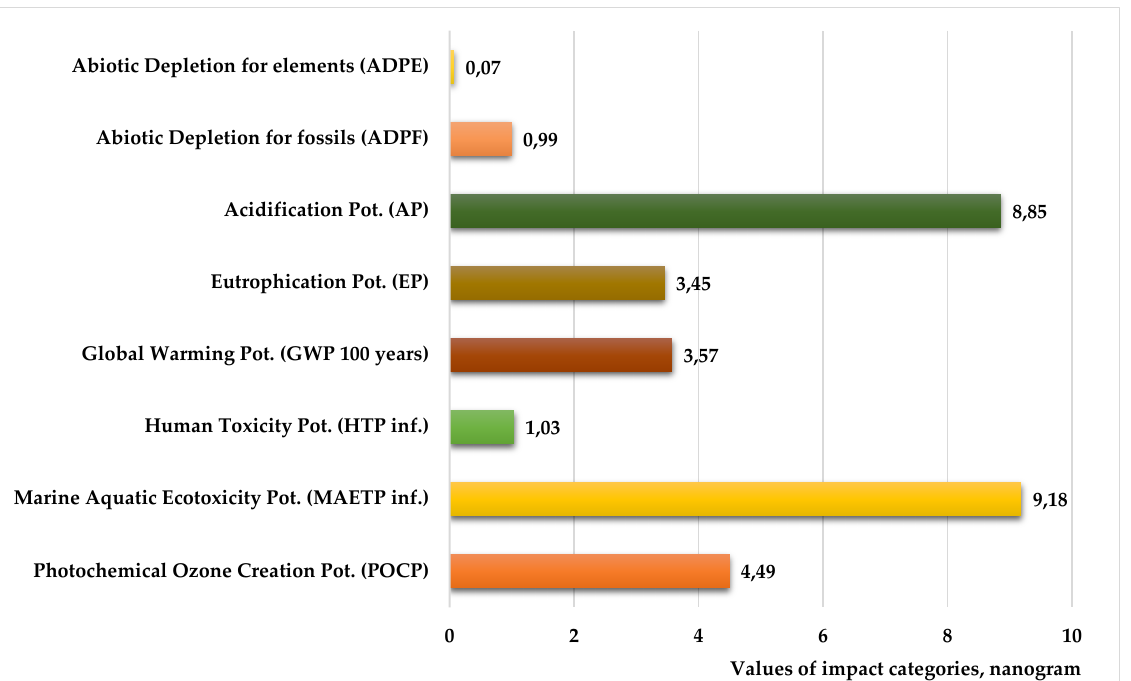
Figure 5. Environmental impact categories in the preparation phase with transport in nanograms (functional unit: food product of 0.427 kg –1 portion. Normalisation reference: CML 2016, EU 25 + 3, year 2000, excl. biogenic carbon. Weighting method: thinkstep LCIA Survey 2012, Europe, CML 2016, excl. biogenic carbon).